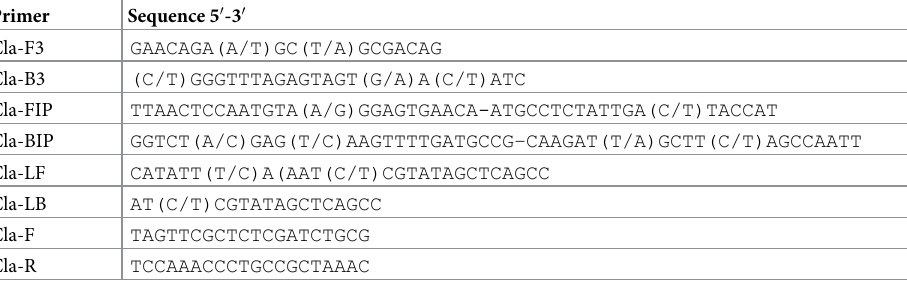
Table 1. Primer sequences of LAMP-HNB and PCR for C . Liberibacter